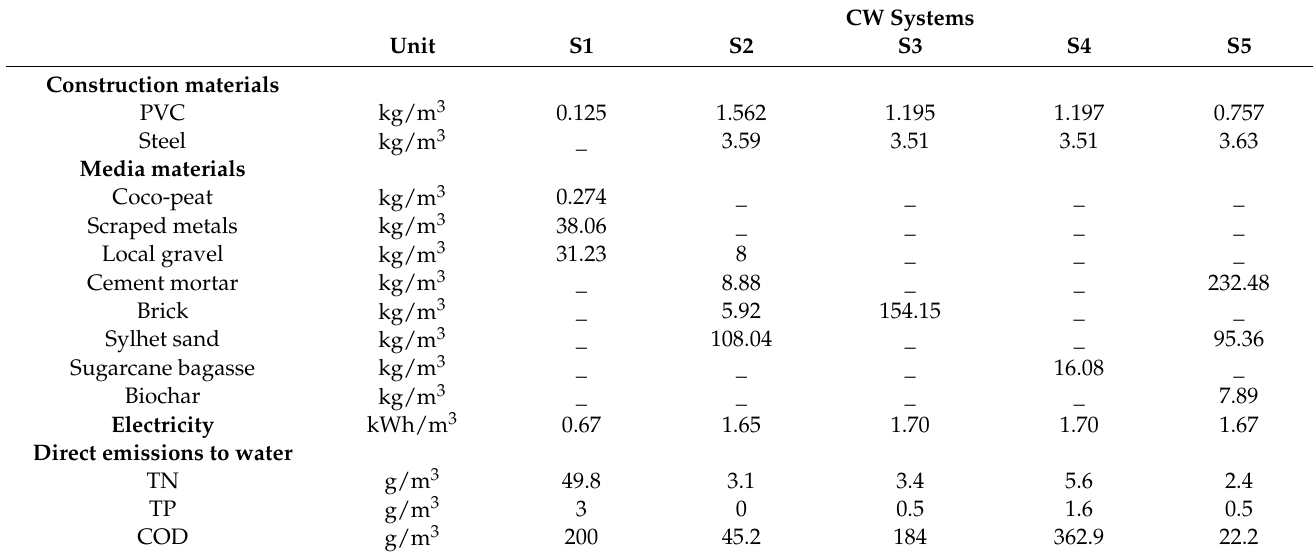
Table 2. Inventory results referred to m 3 of wastewater treatment for considered constructed wet- land